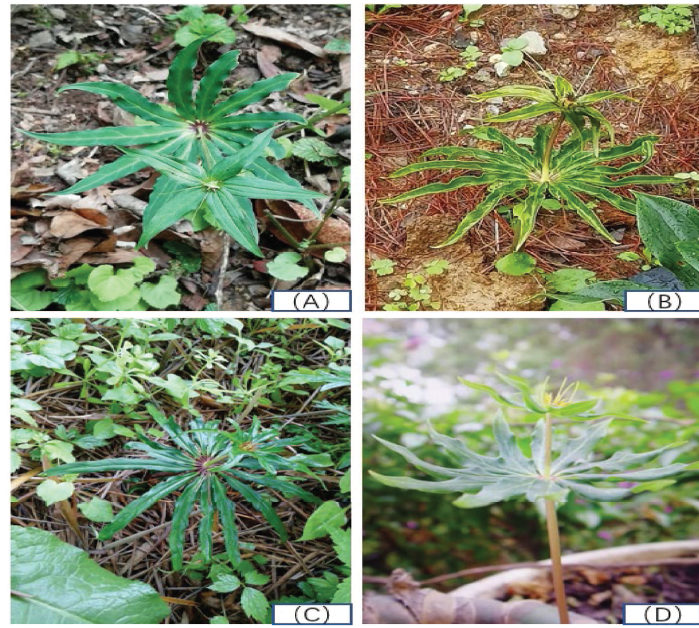
Fig. 2 Paris panxiensis ; garden planting and indoor